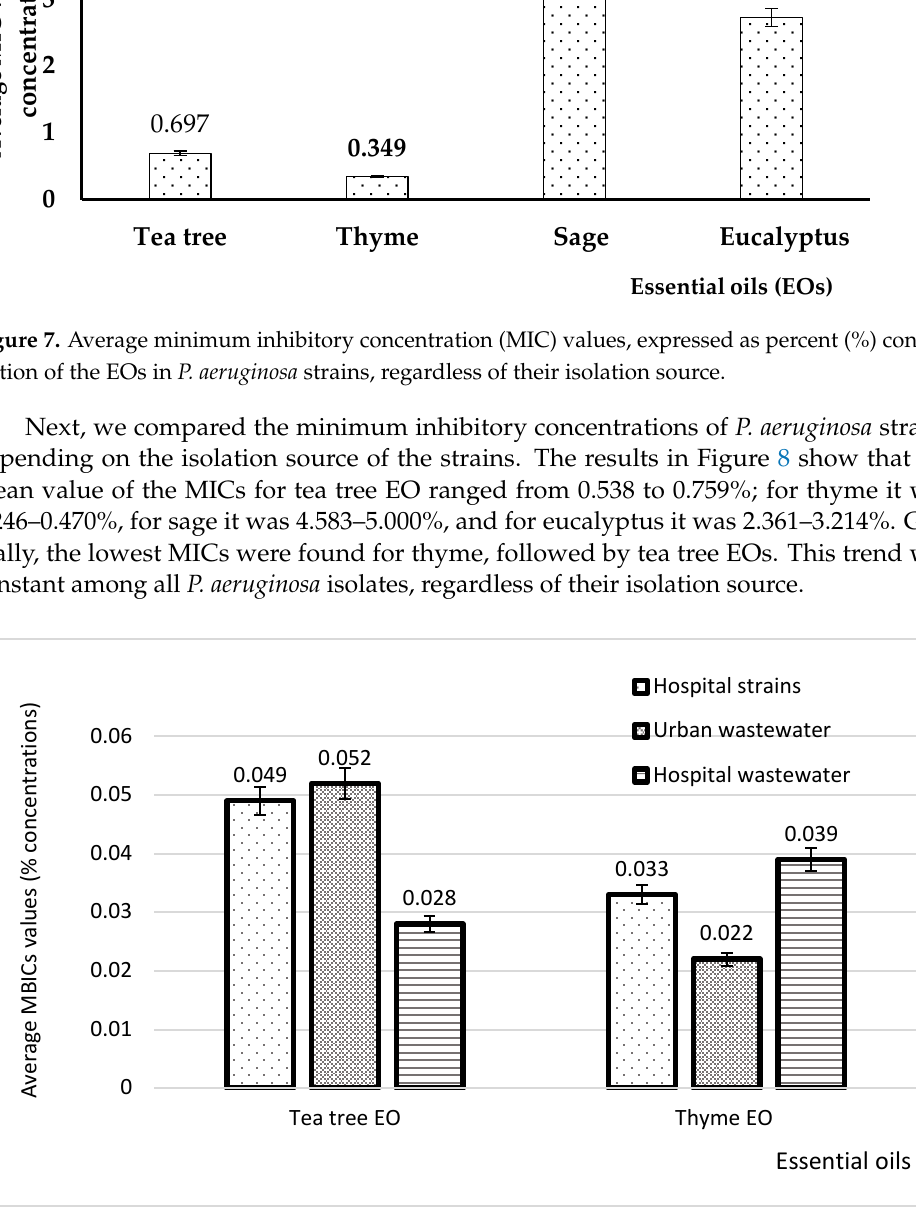
7 of 21 Figure 6. Graphic representation of the average inhibition diameter zone of the EOs in P. aeruginosa strains, regardless their isolation source. Quantitative assays revealed two key parameters, namely, minimum inhibitory con- centration (MIC), and minimum biofilm eradication concentration (MBEC). These were utilized to show the efficiency of the analyzed EOs in planktonic (free floating) and at- tached (biofilms) bacteria cultures. The results gave various MIC values, depending on the analyzed EO, being influ-